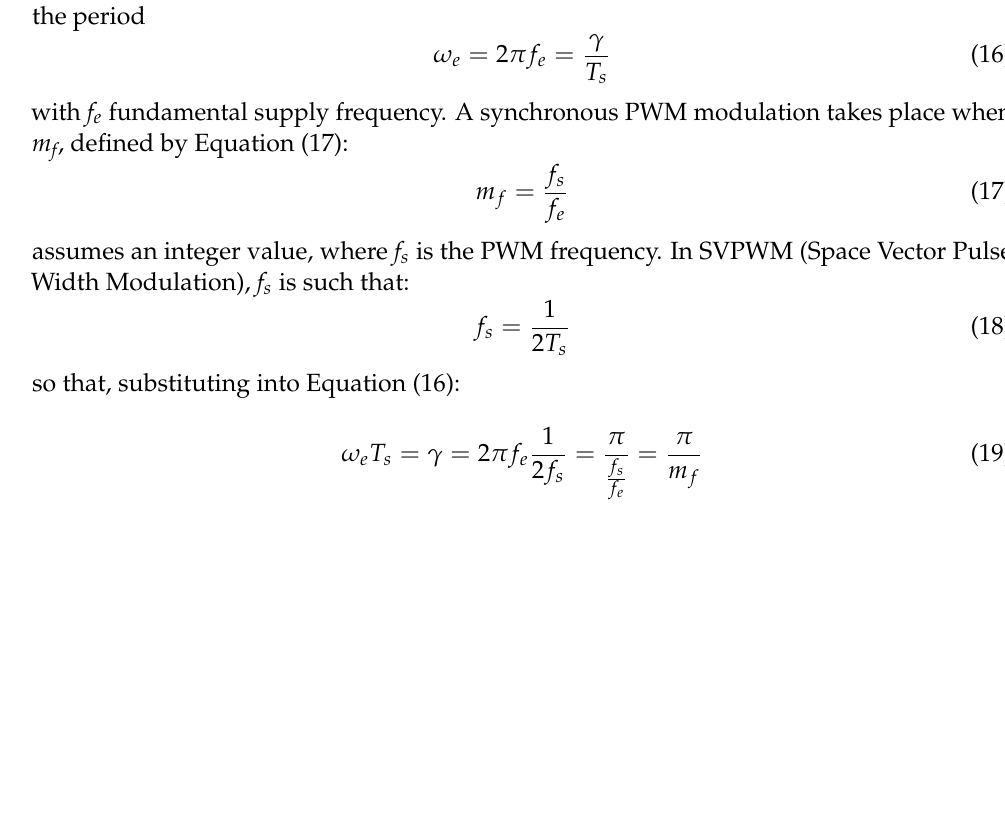
Figure 6. A flowchart of synchronous direct torque control scheme.